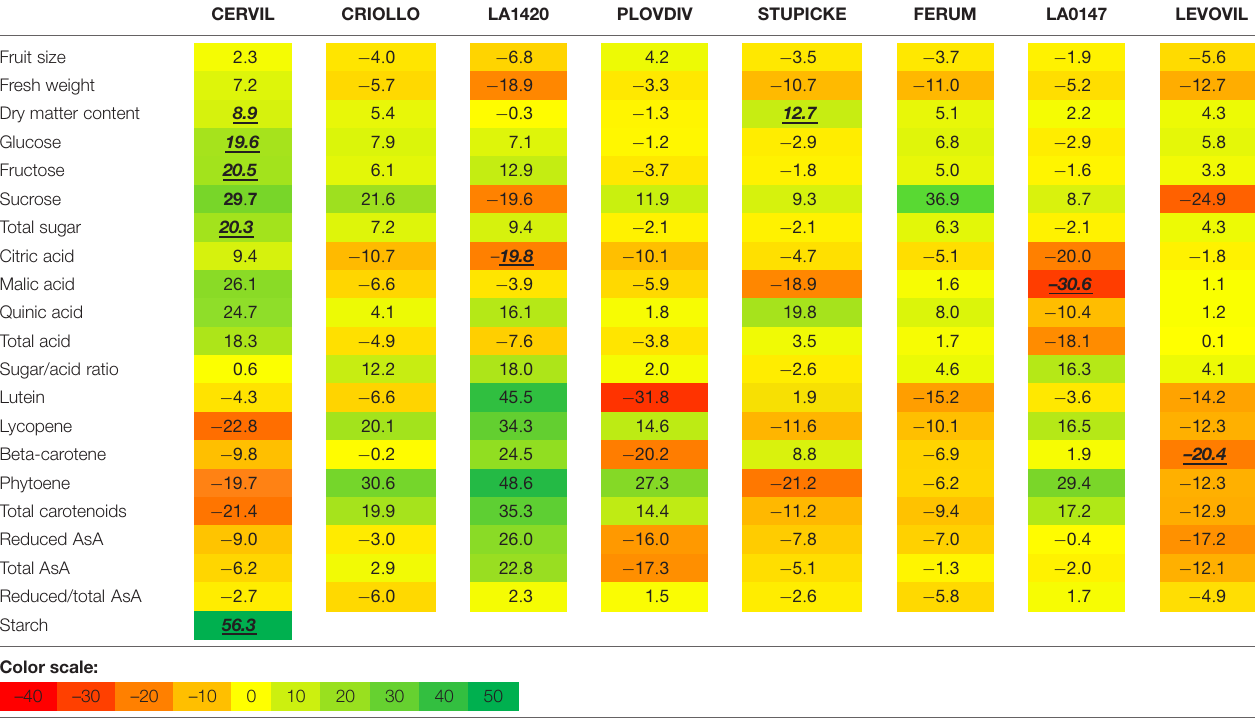
Soluble sugars, organic acids, AsA, and carotenoids were measured on a dry mass basis for the eight MAGIC TOM parents. Relative differences were calculated as described in the legend of Table 2 . The percentages were scaled by color (green for high and red for low values). S1 fruits were harvested at RP2 after a first WD period during cell division (WD1) and a second WD period during cell expansion (WD2). Significant differences are indicated by red bold, italic, and underlined fonts for P < 0.05 (Two-way ANOVA test or Kruskal–Wallis test). and Plovdiv (respectively, + 23.5, + 31.2, and + 30.3% reduced